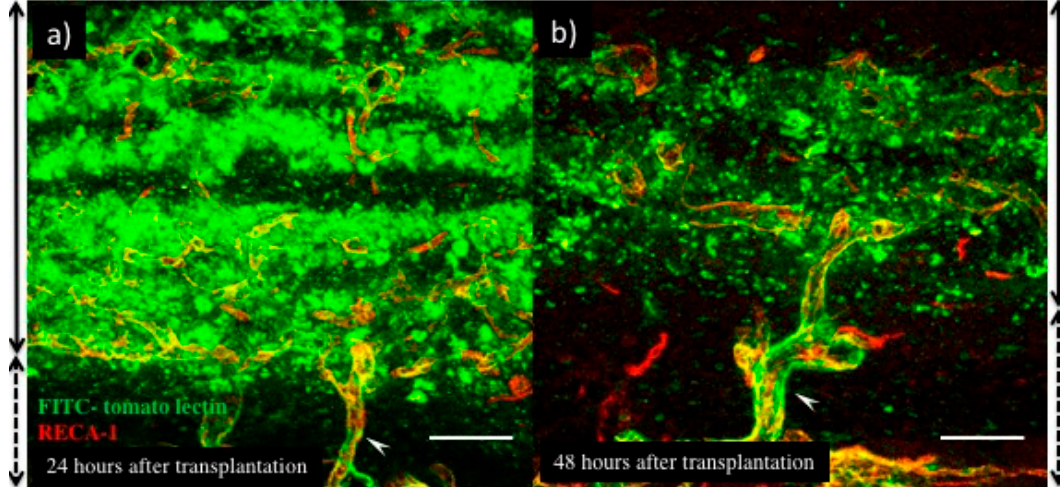
Figure 3. Fluorescein isothiocyanate (FITC)-tomato lectin perfused in host rats 24 h ( a ) or 48 h ( b ) after myocardial cell sheet transplantation. Green indicates FITC-tomato lectin and red indicates RECA-1 positive ECs. Side solid lines with two directional arrows indicate the transplanted cell sheets area, and short dashed lines with two directional arrows indicate host tissues. White arrows were indicated as a host-graft connection vasculature. Scale bar: ( a , b ), about 100 µ m. (The scale bar was added with estimation from original data.)